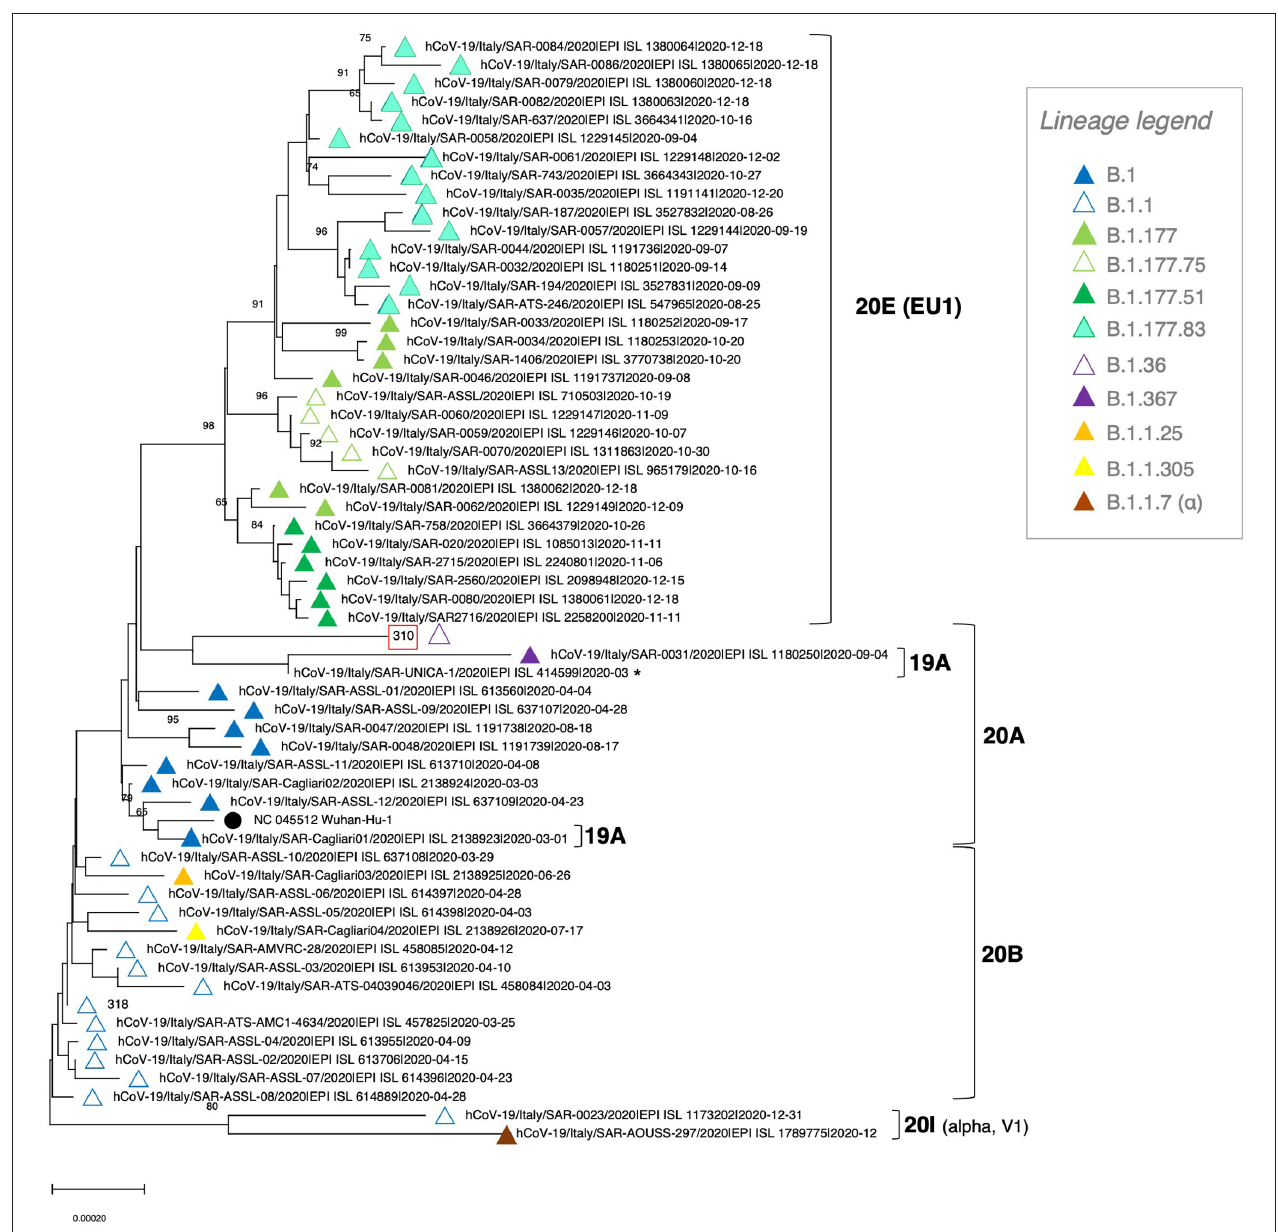
FIGURE 2 | Phylogenetic tree of SARS-CoV-2 genomes circulating in Sardinia in 2020. A total of 57 viral genomes collected in Sardinia during the year were retrieved from GISAID and analyzed with the NJ method, applying the pairwise deletion option. Phylogenies were tested with 100 bootstrap replicates. The SARS-CoV-2 reference sequence (NC_045512) was also included. The color code for SARS-CoV-2 lineages is reported in the legend, while the corresponding viral clades are indicated with squared brackets.